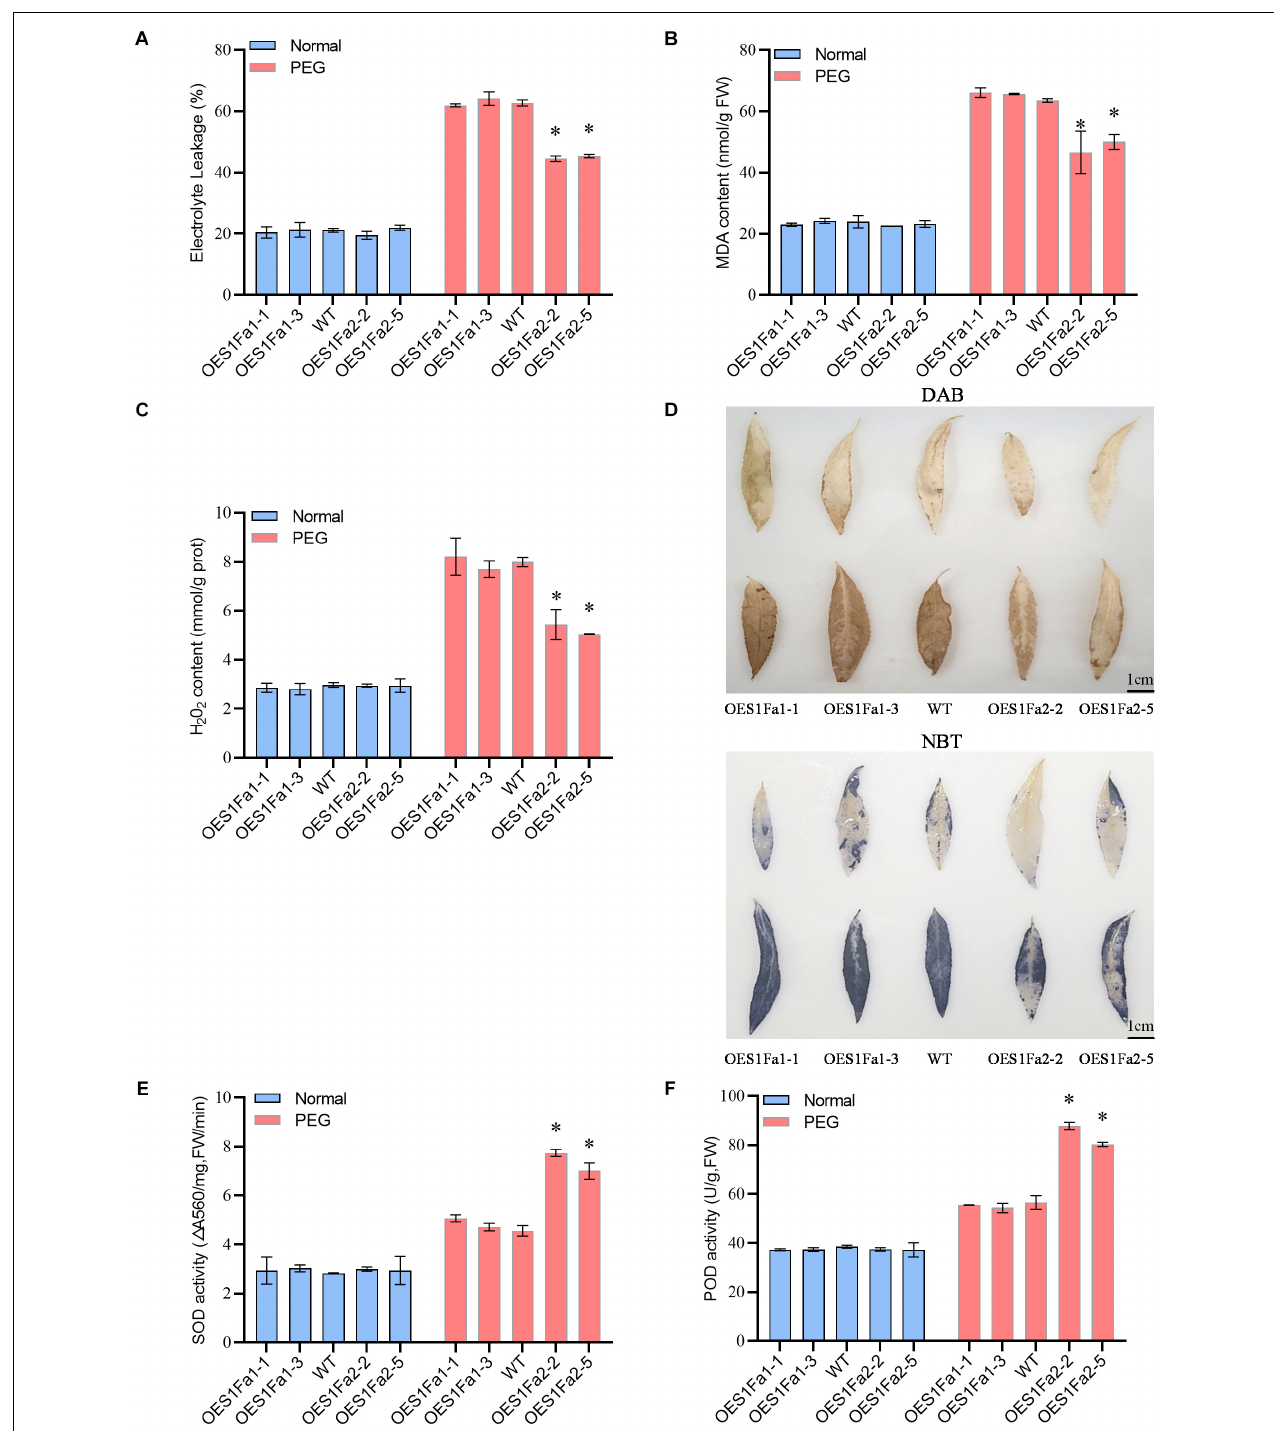
FIGURE 7 | Analysis of ROS scavenging regulated by PtS1Fa1 and PtS1Fa2 . (A) Analysis of relative electrolyte leakage among WT, OEPtS1Fa1, and OEPtS1Fa2 plants. (B) MDA analysis of WT, OEPtS1Fa1, and OEPtS1Fa2 plants. (C) Analysis of H 2 O 2 levels. (D) Detection of O 2 − and H 2 O 2 − using NBT and DAB staining. The poplar plants were exposed to 20% PEG6000 for 0 (without stress) or 9 h, and their leaves were detached for NBT and DAB staining. (E) Measurement of SOD activity among WT, OEPtS1Fa1, and OEPtS1Fa2 plants. (F) Measurement of POD activity among WT, OEPtS1Fa1, and OEPtS1Fa2 plants. Each sample contains at least 3 plantlets. The error bar represents the standard deviation (STD) of the three biological repetition. Asterisks ( ∗ ) indicates significant differences between transgenic strains and WT ( P > 0.05).